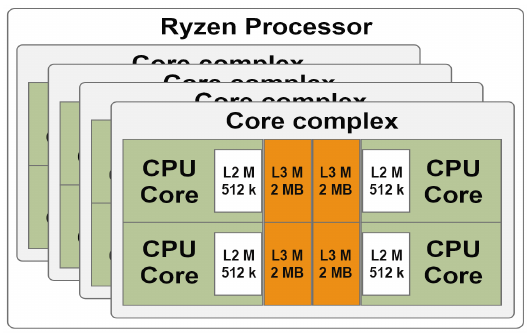
Figure 3. The architecture of a Ryzen processor.